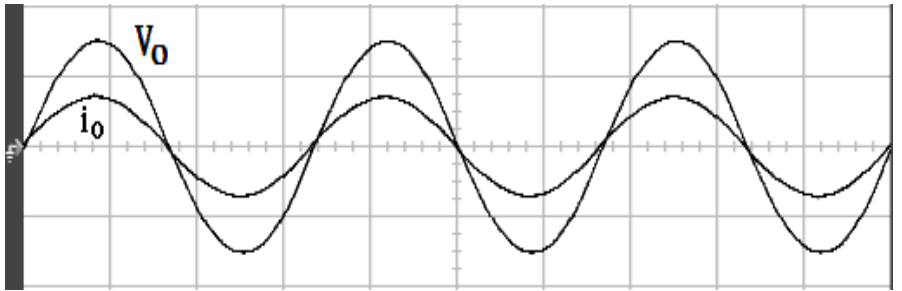
Figure 7. Output voltage and current for experiment of the conventional limited-time convergent VSC at full load (vertical: 100 V/div and 20 A/div; horizontal: 5 ms/div).